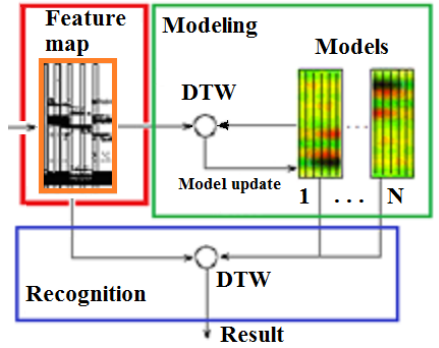
Figure 20. Structure of the closed dictionary case of spoken command recognition.